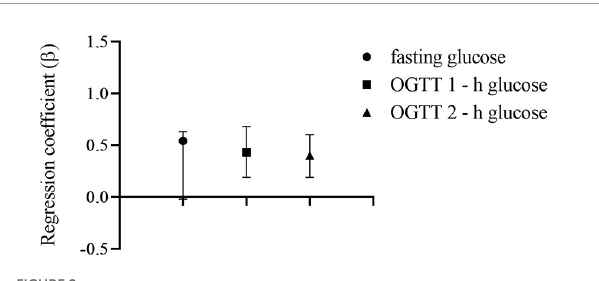
FIGURE2 Association (regression coefficients ± 95% CIs) of ART with maternal OGTT glucose levels, reference to control group of women who conceived spontaneously. All models were adjusted education, occupation, smoking, passive smoking, age, pre-pregnancy BMI, abortion history, PCOS, GDM history, macrosomia, family history of diabetes and family history of gestational diabetes. Among all the 2,258 women of which 2,031 were spontaneous conception and 227 were receiving ART.